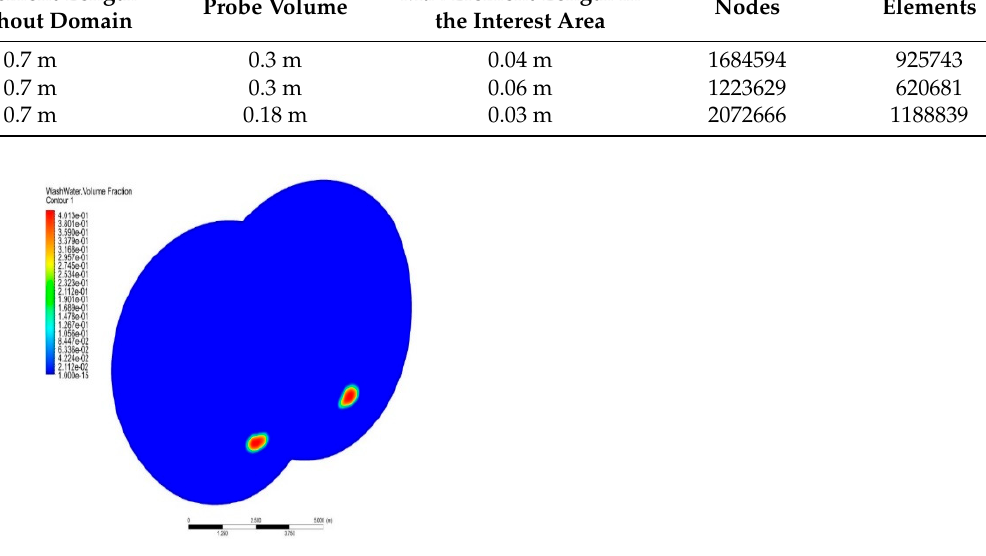
Figure 5. Maximum Volume Fraction values for the Scrubber Wash Water (initial mesh).